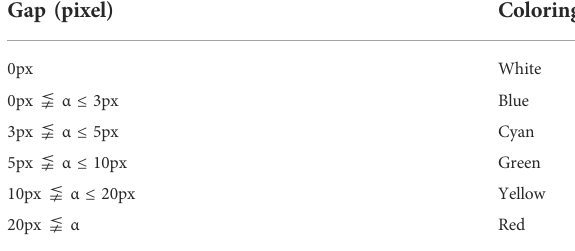
TABLE 3 The performance of damage detection. Image no.